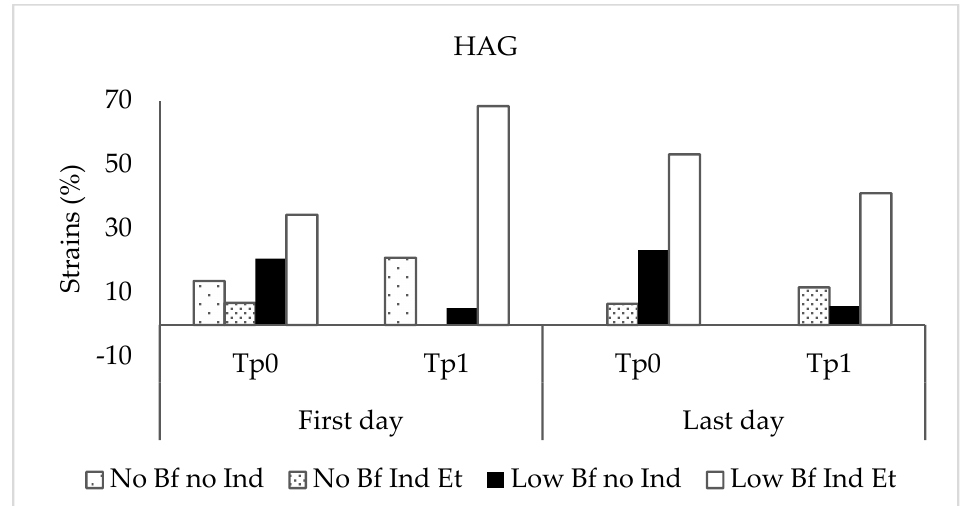
Figure 2. Proportion of strains according to the ability of ethanol to induce or increase biofilm production at different stages of the study. Non-HAG: volunteers who did not use alcohol-based gel; HAG: volunteers who used alcohol-based gel. No BF no Ind: biofilm-negative strains, non-ethanol-inducible; No BF Ind Et: biofilm-negative strains, ethanol-inducible; Low BF no Ind: low-grade biofilm-producing strains, not inducible by ethanol; Low BF Ind Et: low-grade biofilm-producing strains, ethanol-inducible.